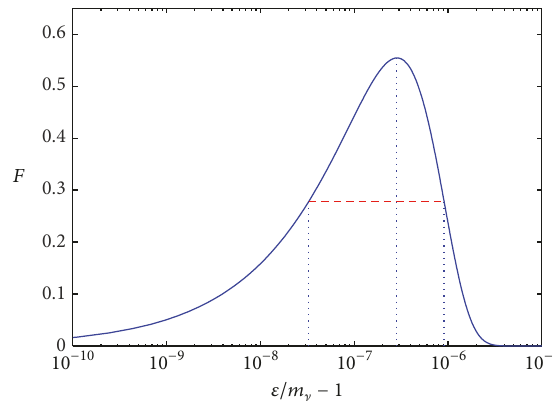
Figure 5: The cross section exhibits resonance behavior. Shown is 𝐹(𝑋) as a function of (𝜖/𝑚 − 1) . ] transition is dubbed as allowed. The nuclear matrix